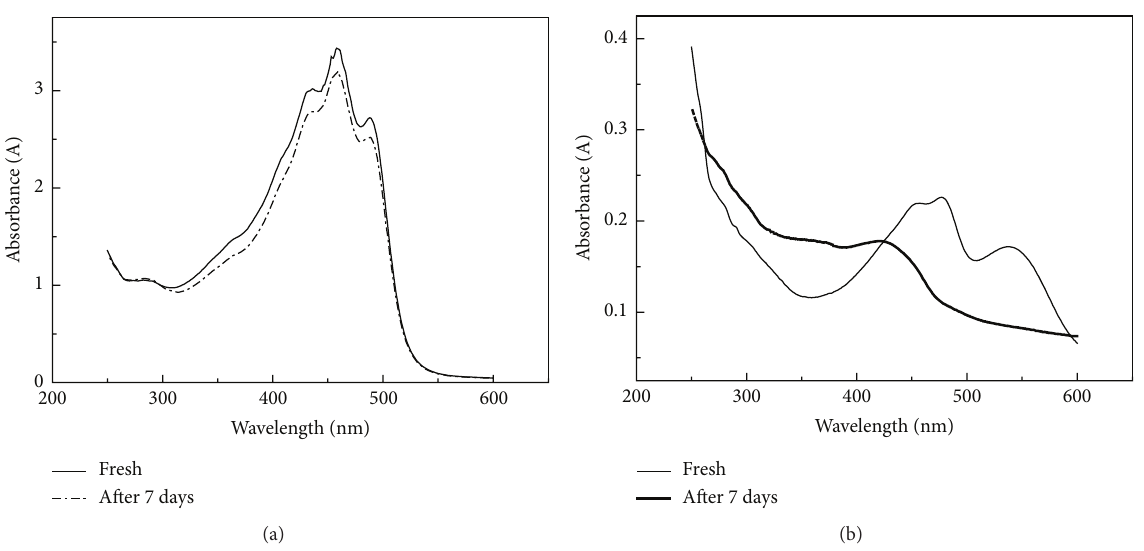
Figure 4: UV-vis spectra in aqueous solution of (a) annatto and (b) beetroot in different storage